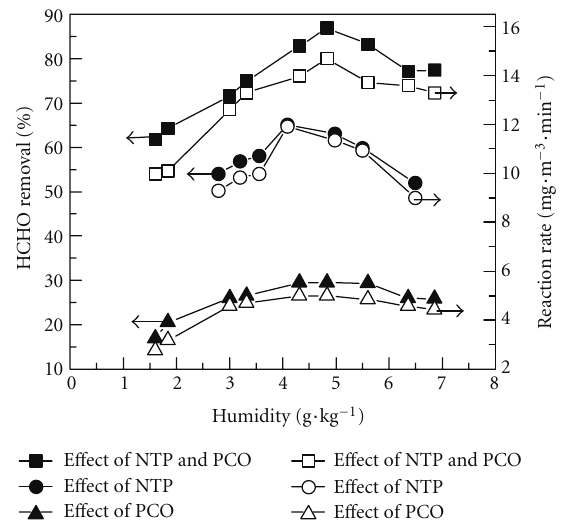
Figure 11: The e ff ect of humidity on the removal and reaction rate of HCHO by di ff erent